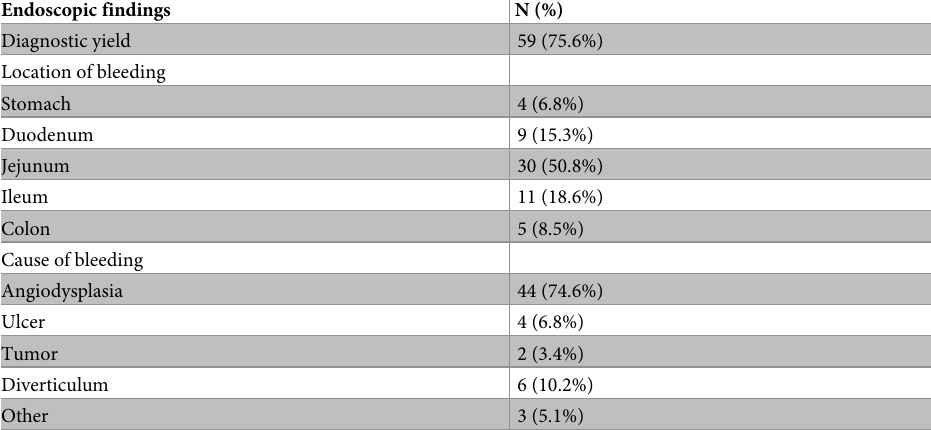
Table 2. Endoscopic findings of uremic patients who underwent single-balloon enteroscopy procedures.